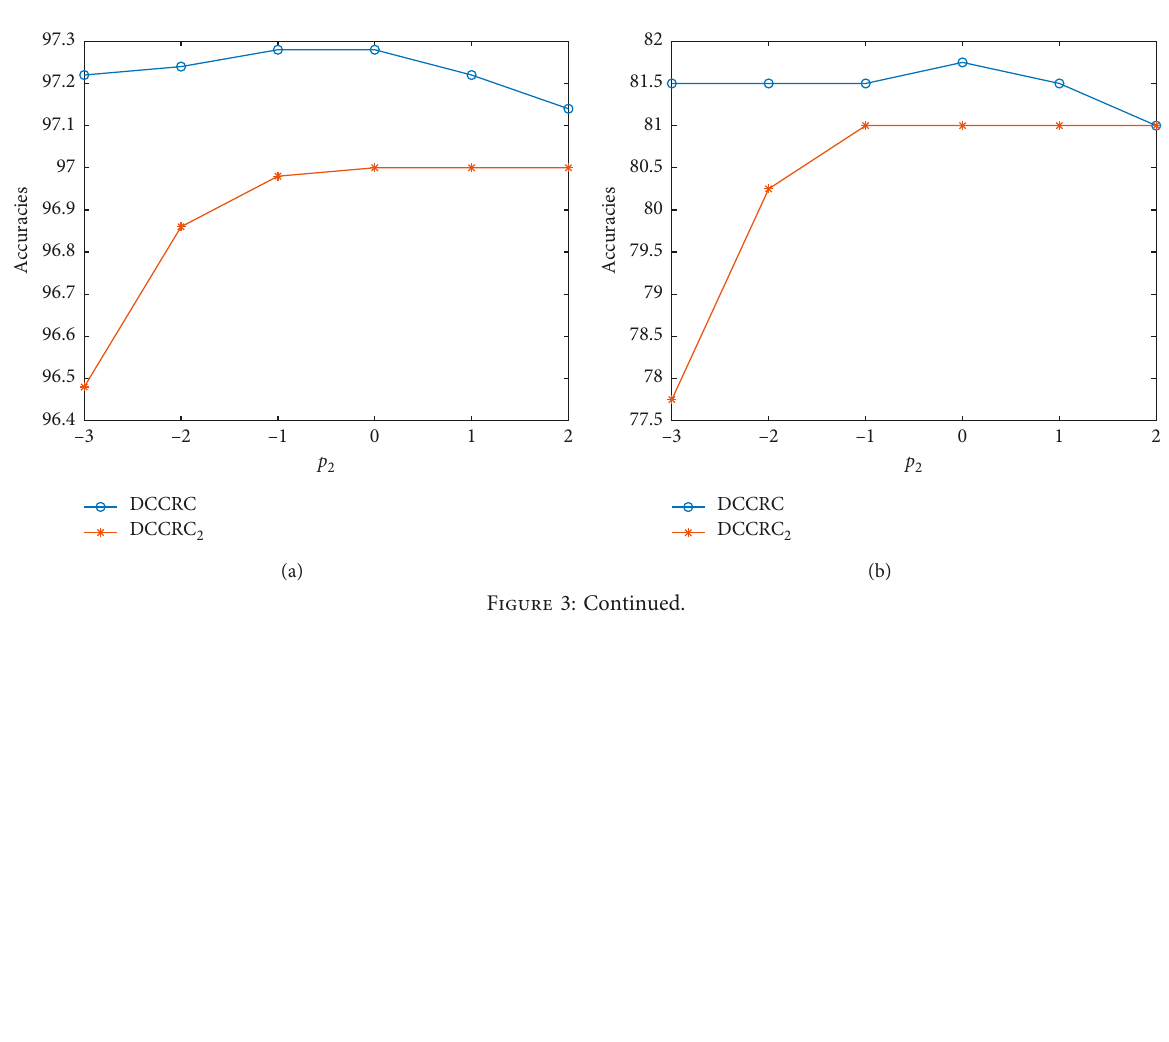
1 with varying values of parameter λ 1 on each face database. (a) AR ( l